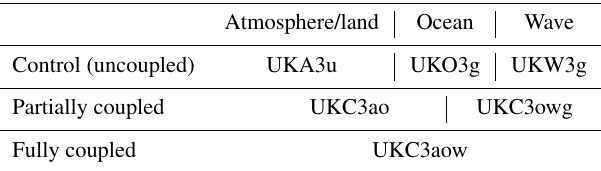
Table 10. Summary of model configurations used for system eval- uation simulations relevant to each model component. See also Ta- ble 2 for configuration